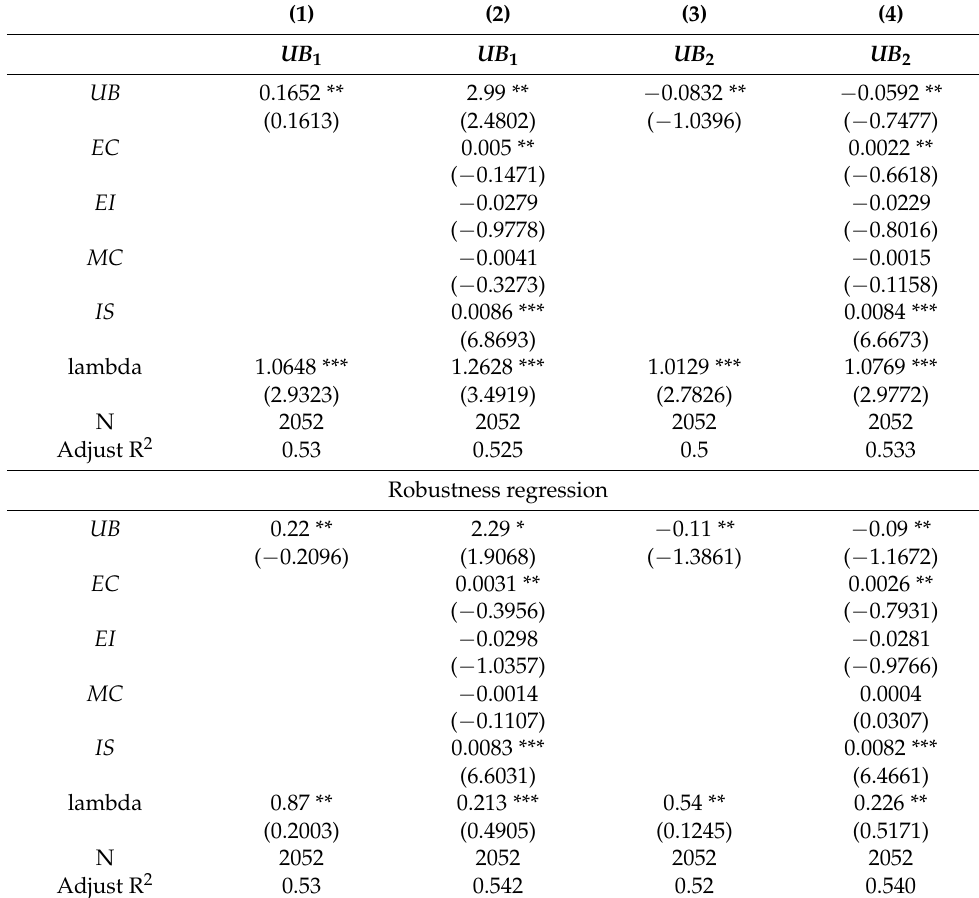
Table 5. Spatial econometric estimation results and robustness